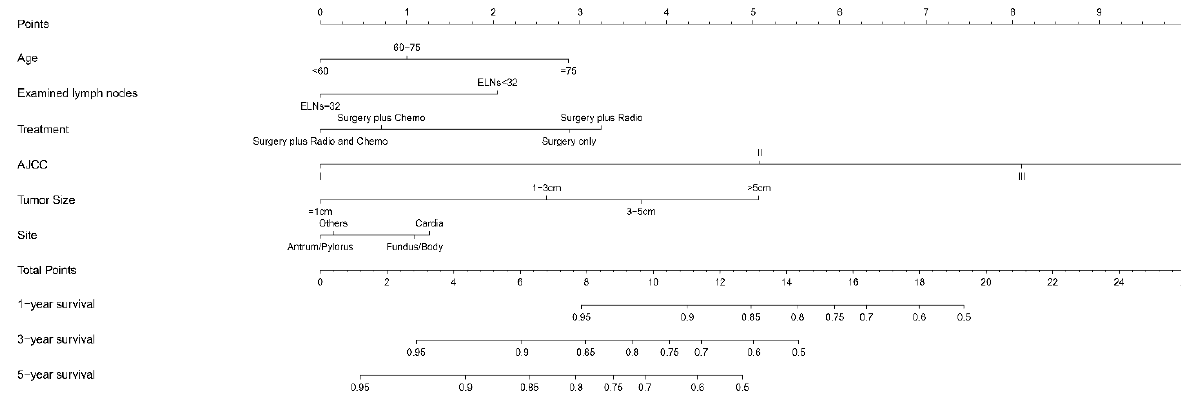
Figure 3. Nomogram based on examined lymph nodes for predicting survival outcome in patients with gastric signet ring cell carcinoma.